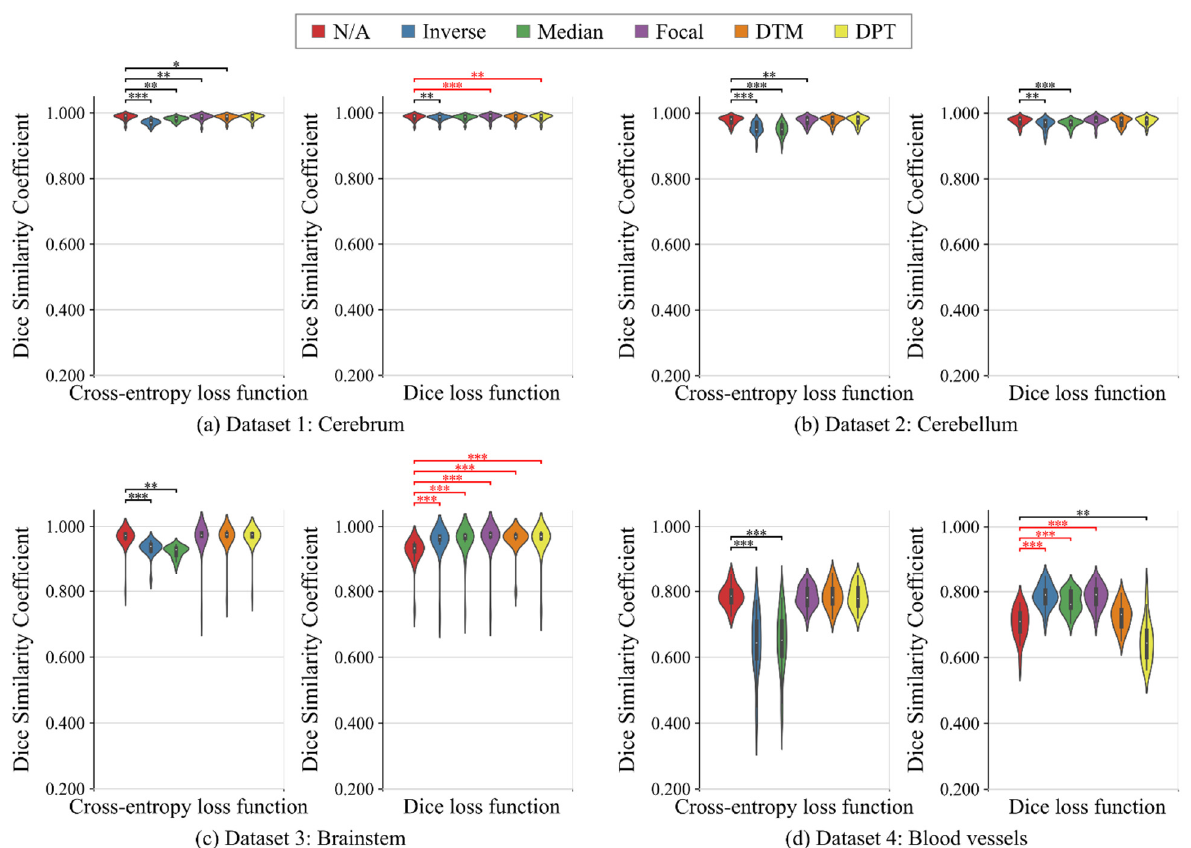
Figure 4. Violin plots of the segmentation results (Dice similarity coefficients) of no weighting (N/A), inverse frequency weighting (Inverse), inverse median frequency weighting (Median), focal weighting (Focal), distance transform map-based weighting (DTM), and distance penalty term-based weighting (DPT) in binary-class segmentation tasks. ( a ) Dataset 1: cerebrum, ( b ) Dataset 2: cerebellum, ( c ) Dataset 3: brainstem, and ( d ) Dataset 4: blood vessels. Compared with the results of N/A, the significantly worse and better results are shown in black and red, respectively (Wilcoxon signed-rank test, * 𝑝 < 0.05 , ** 𝑝 < 0.01 , and *** 𝑝 < 0.001 , not adjusted for multiplicity).